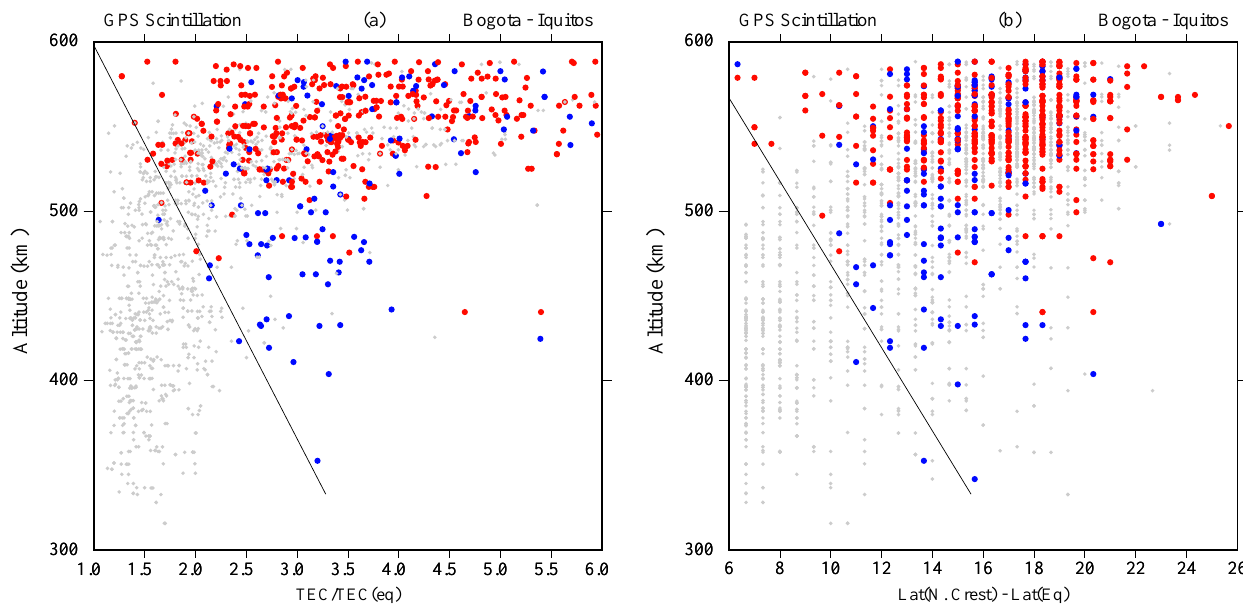
Fig. 12. Distribution of the hm F2 values as a function of the crest-to-trough ratio (panel (a) and vs. the crest separation (panel (b) ), binned according to the presence (colored dots) and absence of GPS scintillations (gray dots). The inclined lines in the left part of each frame have been fitted to the minimum values of the crest/trough ratio (or crest separations) for different altitude